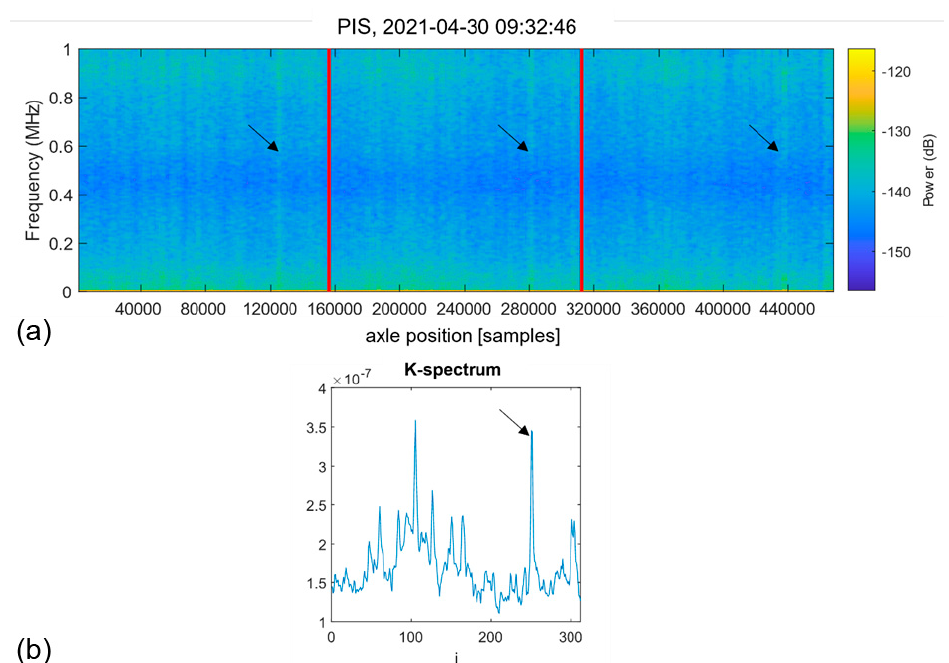
Figure 6. Example of the pulse integration spectrum corresponding to one axle revolution divided into three segments of equal length and marked by vertical red lines ( a ) and the K -spectrum corresponding to the middle segment ( b ) highlighting the presence of damage recurring in the waveform with the 𝑓 (cid:3033)(cid:3028)(cid:3048)(cid:3039)(cid:3047) = 3/𝑟𝑒𝑣 frequency. Characteristic spectral lines are indicated by black arrows.